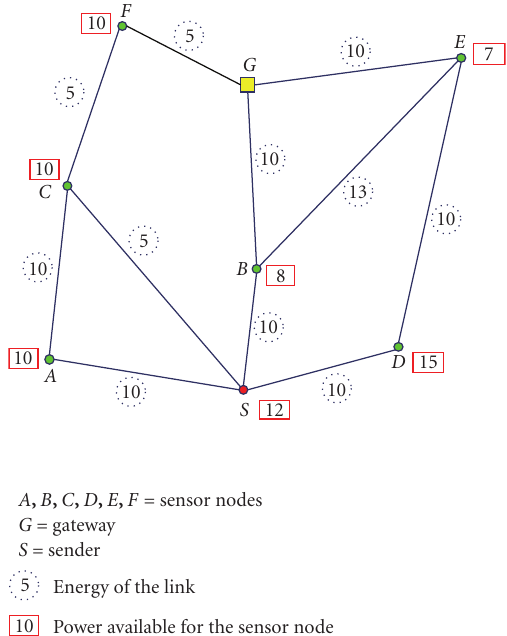
Figure 4: Network model considered in Section